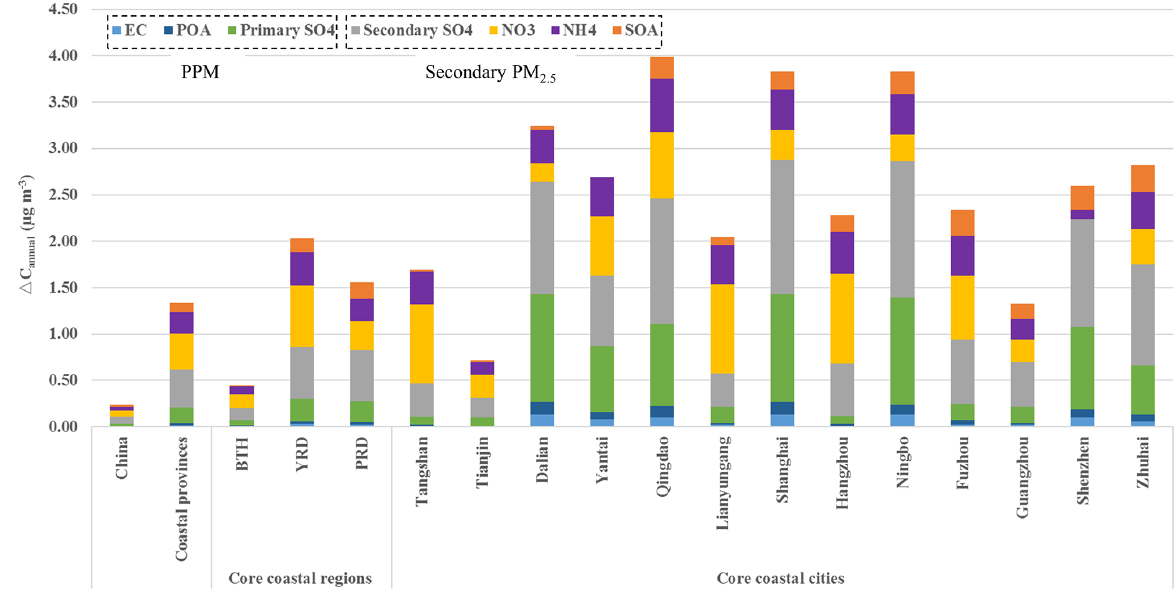
Figure 4. Contributions of shipping emissions to the annual mean concentrations of total PM 2 . 5 and detailed species in core coastal regions and cities (base case – no ship